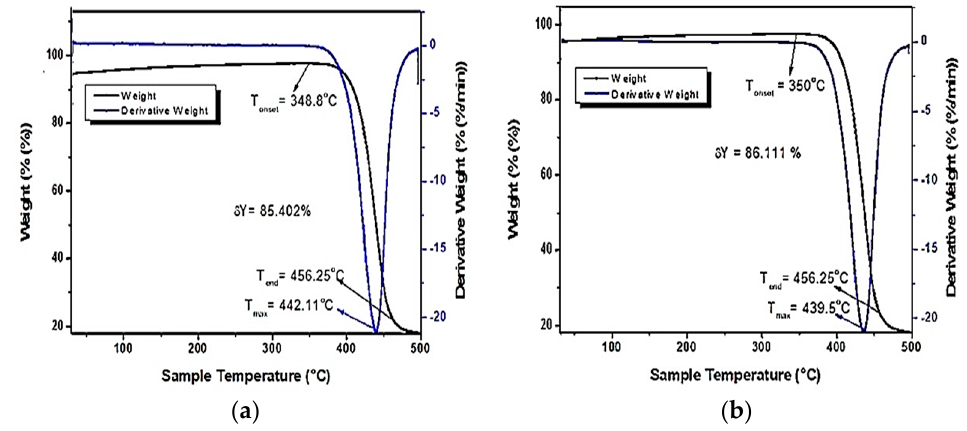
Figure 3. TG/DTG thermograms for WPET (a) before gamma − irradiation (b) after gamma − irradiation.